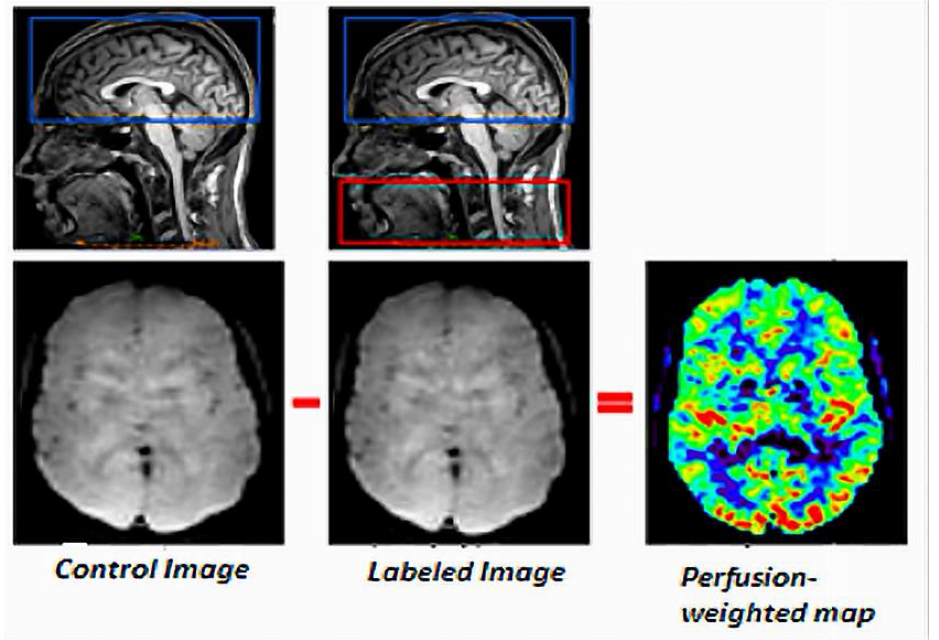
Figure 1. General principle of ASL.